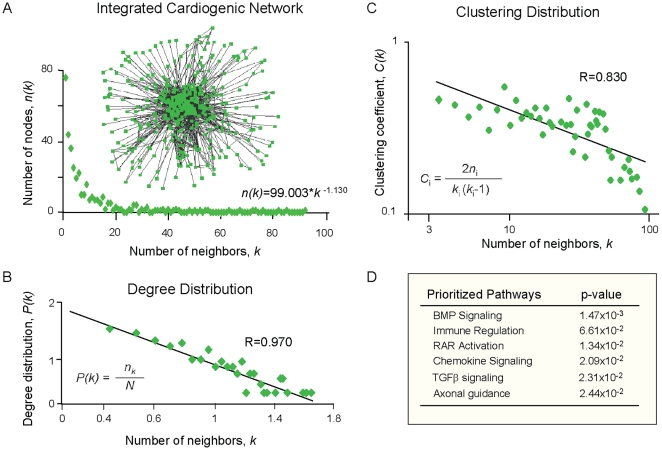
Conserved gene expression between progenitor transcriptomes extracts a network with quantifiable topology.(A) Ingenuity built an integrated cardiogenic scaffold of 363 molecules (i.e., network nodes) connecting the 288 progenitor shared genes and their direct, database predicted biological partners. Cytoscape interaction analysis decoded 1801 direct molecular relationships (i.e., network edges). X-axis represents the number of neighbors, k, for each network node. Y-axis, n(k), represents the number of nodes with k neighbors and follows a power-law equation, with the majority of nodes having few connections and several highly connected nodes. The average calculated degree of the network, i.e., average number of neighbors for each gene (k) was 9.5. (B) The degree distribution, P(k), established a linear correlation (R = 0.970) on the log-log scale with the number of neighbors, k, a feature characteristic of scale-free networks. (C) The clustering coefficient, C(k), was calculated according to the inset formula, and correlated (R = 0.830) on a log-log scale with the number of neighbors, k. A linear logC(k) distribution denotes the hierarchical nature of the network. (D) The prioritized canonical pathways within the integrated network included BMP2, CXCR4/chemokine and TGFβ signaling.